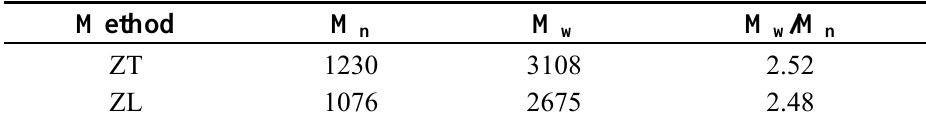
Table 3. Results of GPC analyses on oxidation products of isoeugenol applying Zutropf (ZT) and Zuluaf (ZL) conditions.